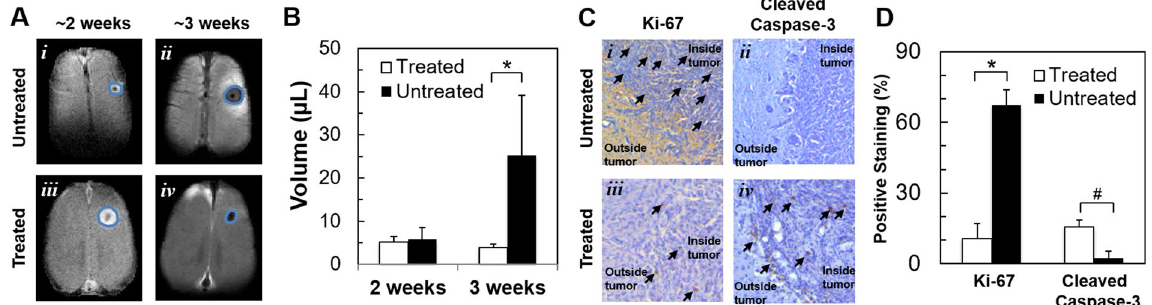
Figure 1. Effect of TMZ treatment on U251 tumor morphology, apoptosis, and proliferation. ( A ) T 1 - and T 2 - weighted MRI at ~2 and ~3 weeks post tumor implantation, respectively, depicting tumor sizes in untreated and TMZ treated U251 tumor bearing rats. The measurements at ~2 weeks and ~3 weeks were, respectively, made by T 1 and T 2 MRI contrast enhacement. In the treated group, the rats were imaged at 12.6 ± 0.5 and 22.8 ± 0.7 days, whereas in the untreated group the rats were imaged at 12.4 ± 2.2 and 22.0 ± 3.3 days. ( B ) Tumor volume in treated and untreated U251 bearing rats at ~2 and ~3 weeks post tumor implantation, where the difference between treated and untreated groups were significant at later stages ( * p = 0.01). ( C ) Ki-67 and cleaved caspase-3 staining in untreated and TMZ treated U251 tumor bearing rats. Arrows point to brown colored positive DAB staining. ( D ) Percentage of cells showing positive staining for Ki-67 and Cleaved Caspase-3. In treated vs. untreated tumors, Ki-67 shows a significant decrease in proliferative index ( * p = 0.025) and cleaved caspase-3 shows a significant increase in apoptotic index (#p =